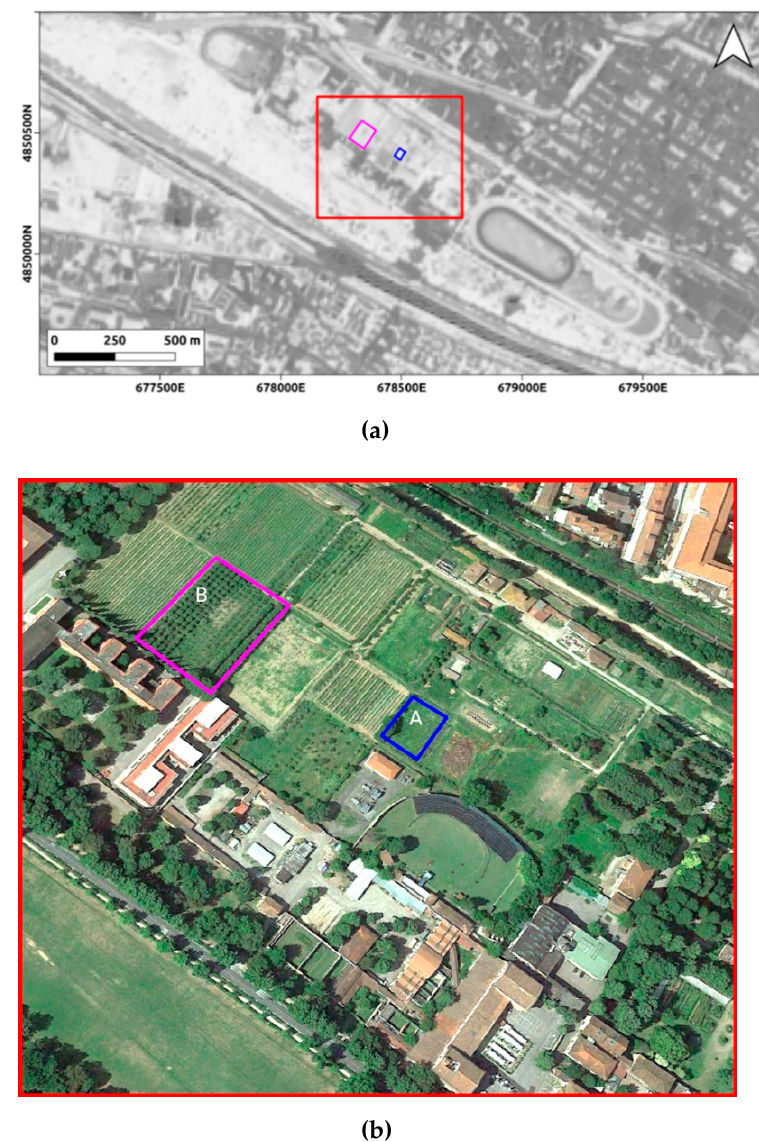
Figure 2. ( a ) Sentinel-2 MSI NDVI image of June 2021 showing the position of the meadow (blue) and the olive grove (violet) within the Cascine urban Park in Firenze; ( b ) Google Earth true colour composite taken in June 2021 showing the position of the SWC probes within the meadow ( A ) and the olive grove ( B ).